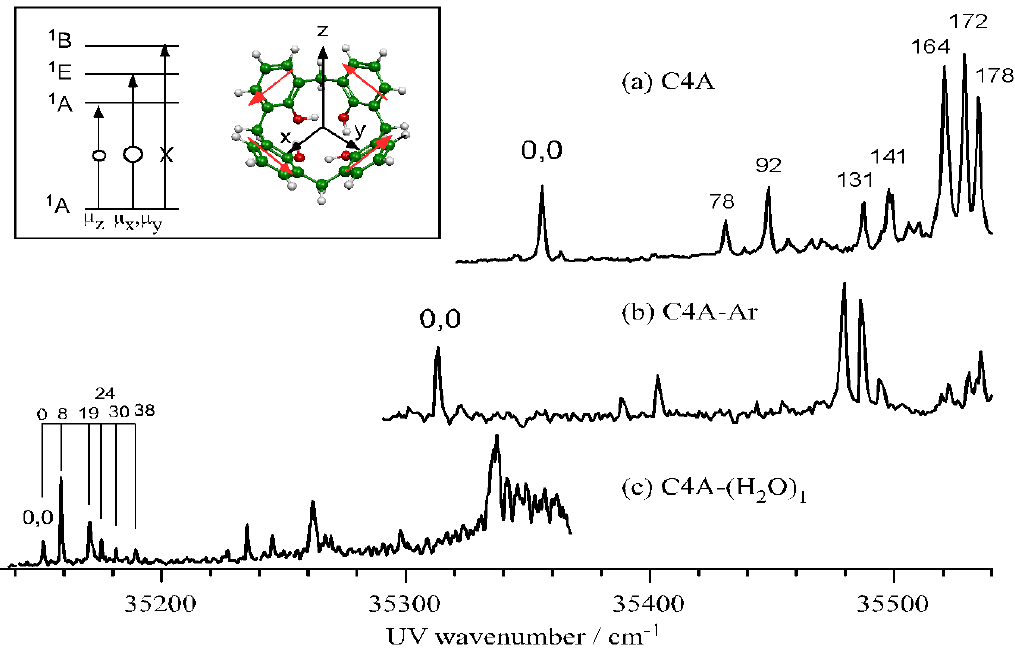
Figure 16. Mass resolved two-color REMPI spectra of (a) C4A, (b) C4A-Ar complex